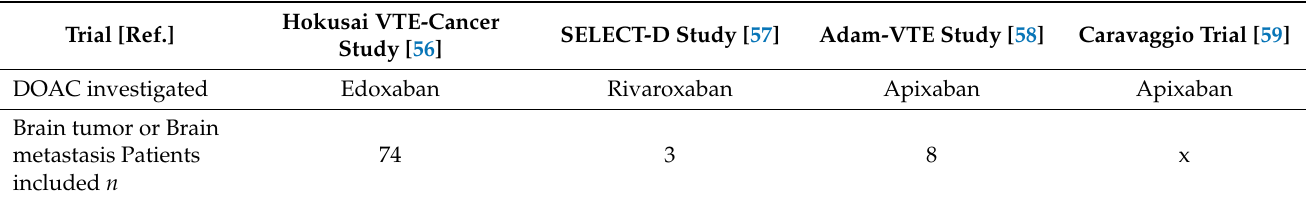
Table 2. Randomized controlled trials, including patients with primary brain tumor or brain metastasis, on safety and efficacy of direct oral anticoagulants compared to low-molecular-weight heparin in the treatment of cancer-associated venous thromboembolism. Trial